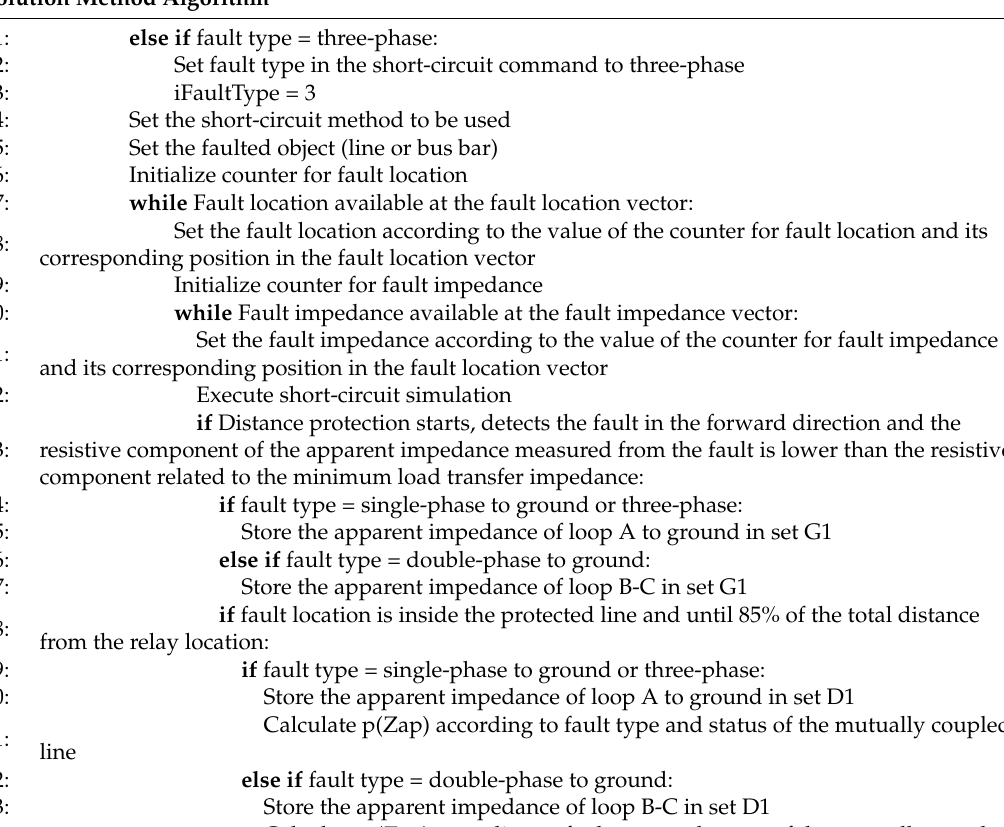
Solution Method